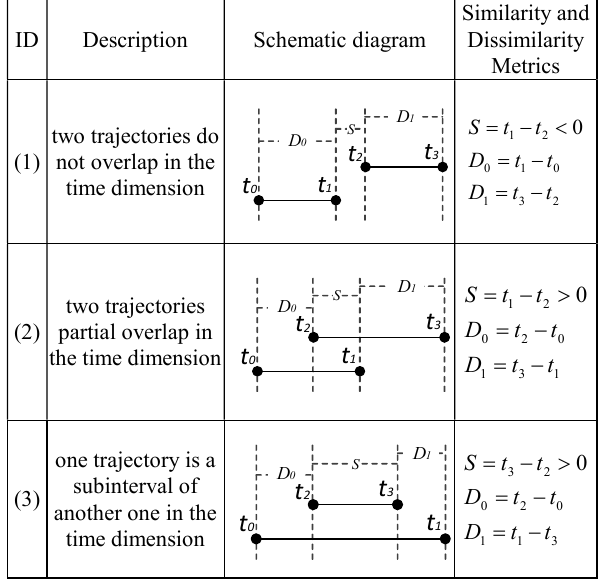
Table 1. Temporal distance description method for spatiotemporal